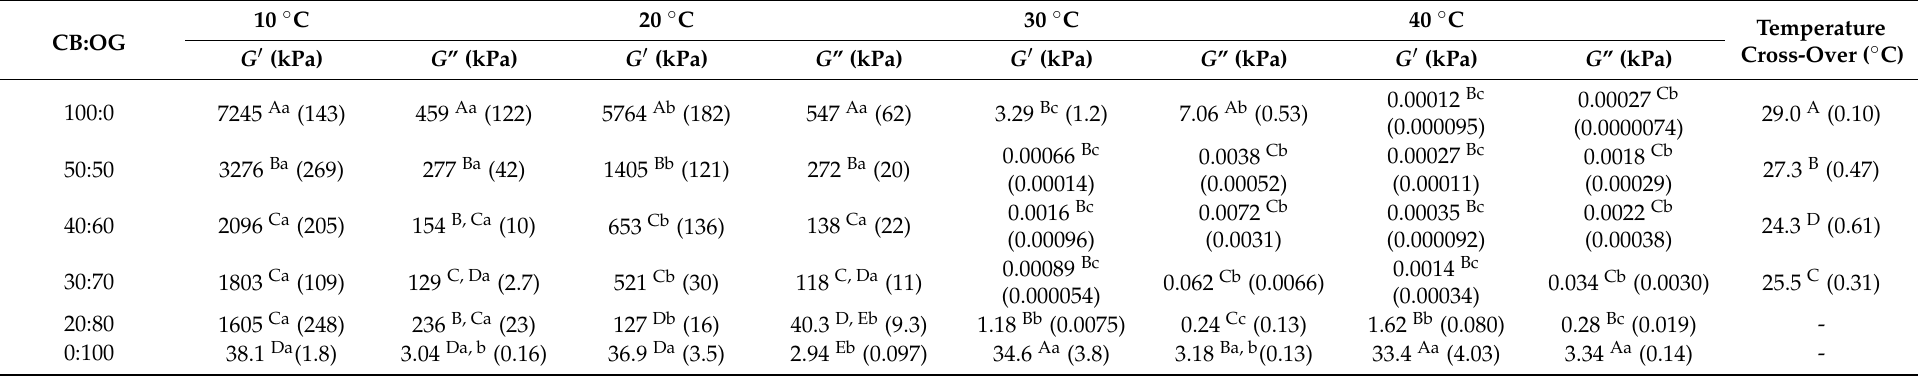
Table 3. Viscoelastic properties derived from dynamic thermomechanical analysis (DTMA) carried out between 10 and 60 ◦ C for the different formulated CB:OG